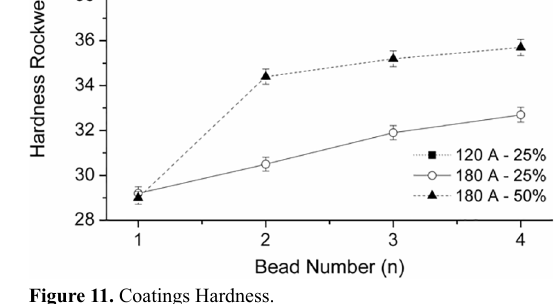
Figure 11. Coatings Hardness.